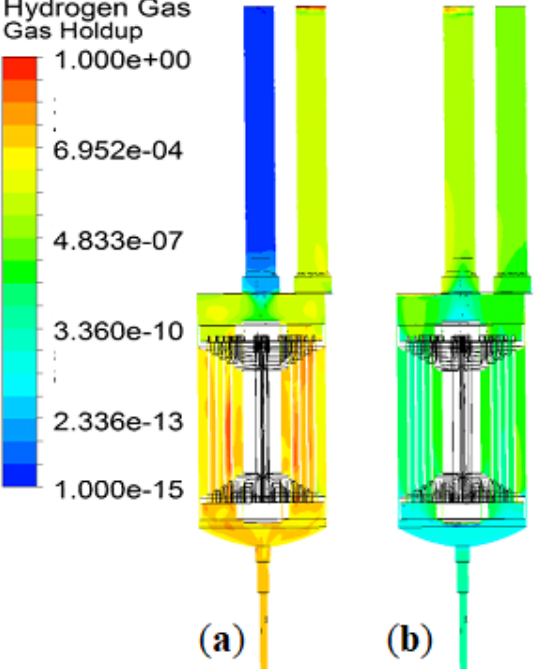
Figure 9. Gas volume fractions before ( a ) and after ( b ) degasification.